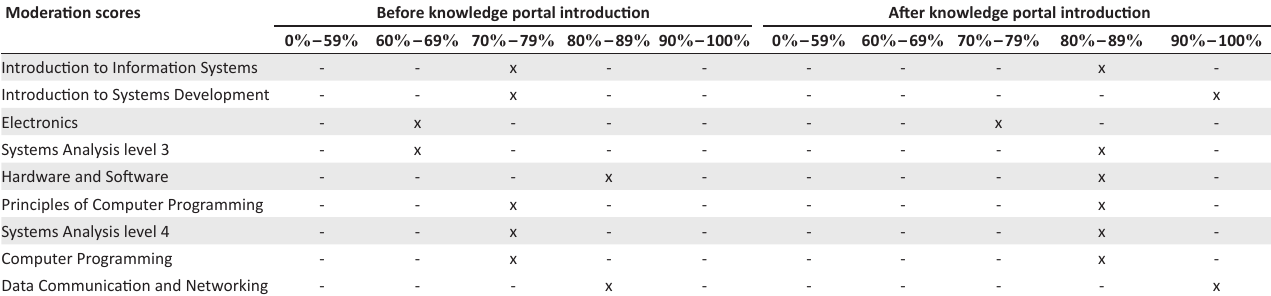
TABLE 4: The comparison of the moderation scores before and after the knowledge portal introduction. Moderation scores